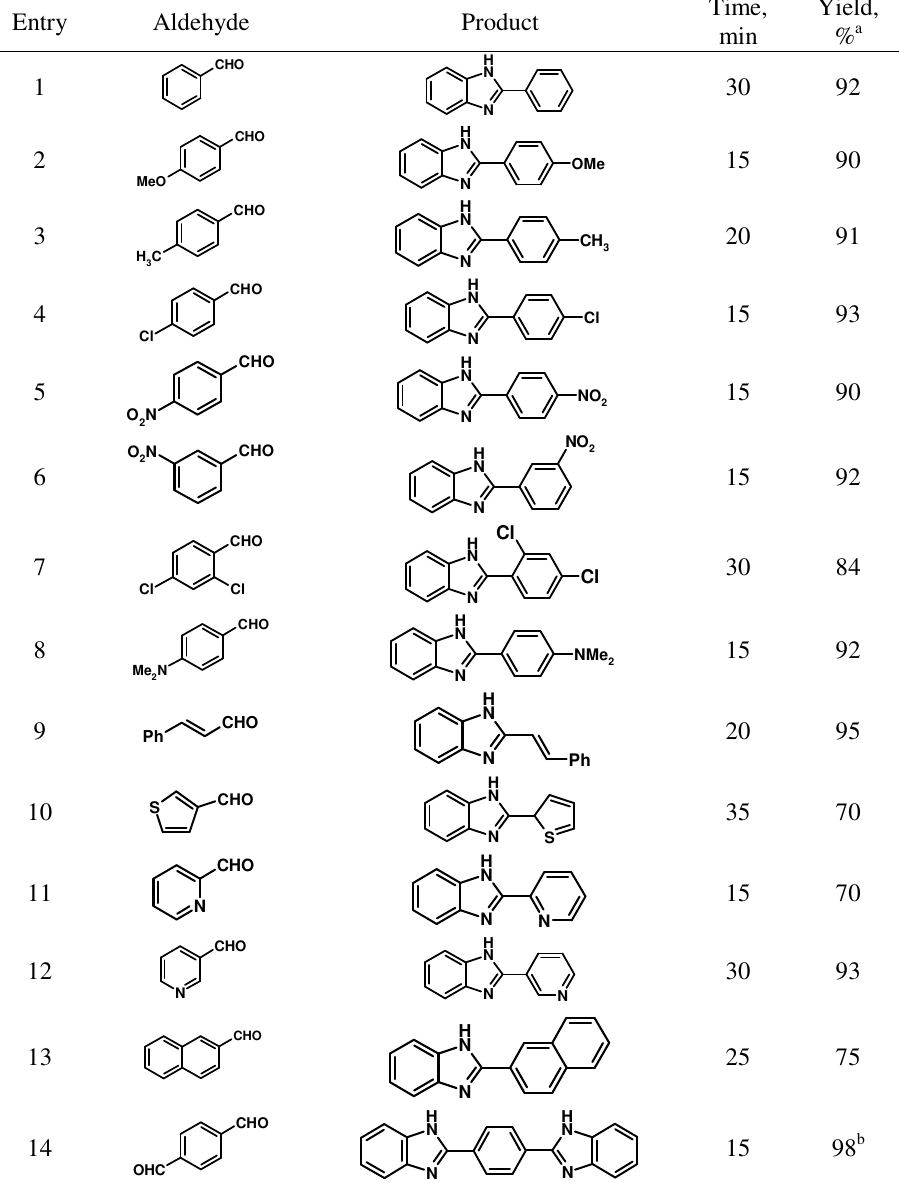
Table 1. Synthesis of 2-substituted benzimidazoles in the presence of boric acid